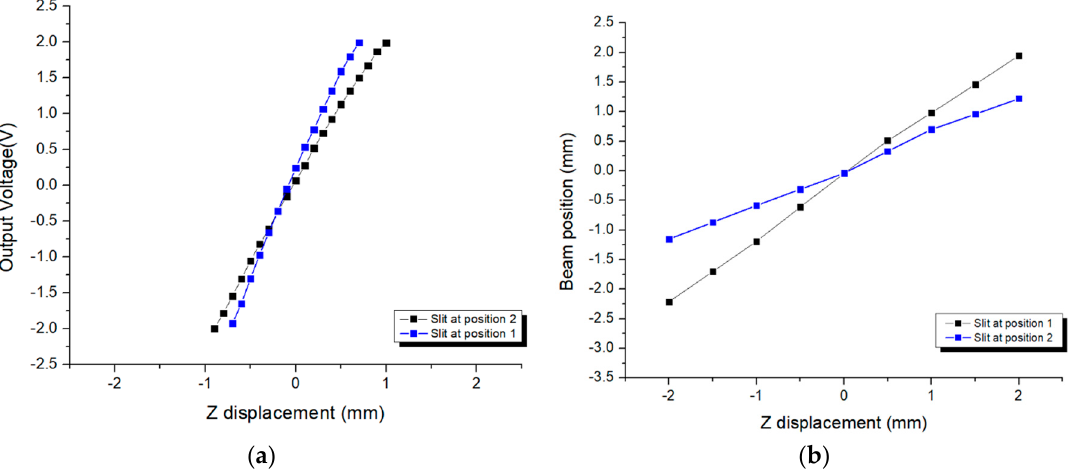
Figure 6. Linear relation between changes in output voltage and specimen position obtained by ( a ) PSD (specimen moving increment of 0.2 mm) and in slit image position and specimen position obtained by ( b ) CCD (specimen moving increment of 0.5 mm).